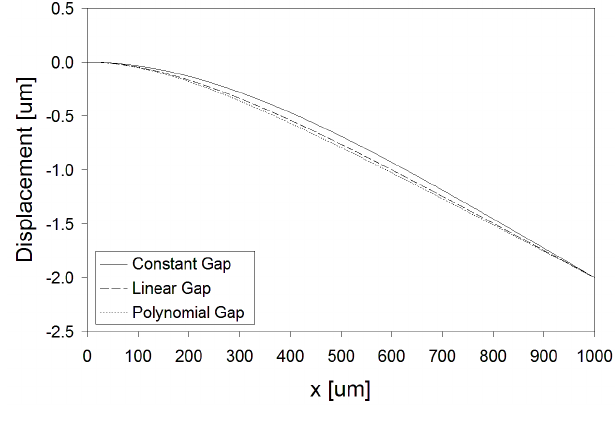
Figure 12. Cantilever beam polynomial gap (n = 1.3333) beam displacement